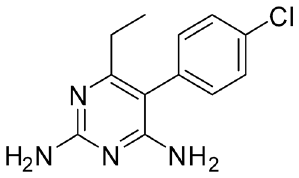
Figure 2. Structure of pyrimethamine.